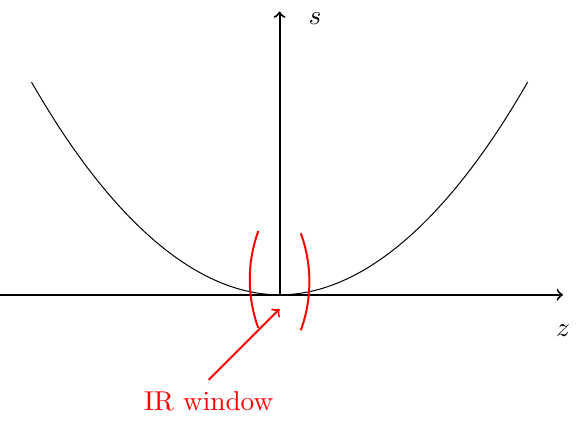
Figure 1 . In the IR, the D2 only probes a tiny neighborhood around s = z = 0 of the curve s (cid:0) z 2 = 0, where the D6 appears to be (cid:13)at. m ! 1 limit is always the one involving the highest spin, which, as before, substitutes